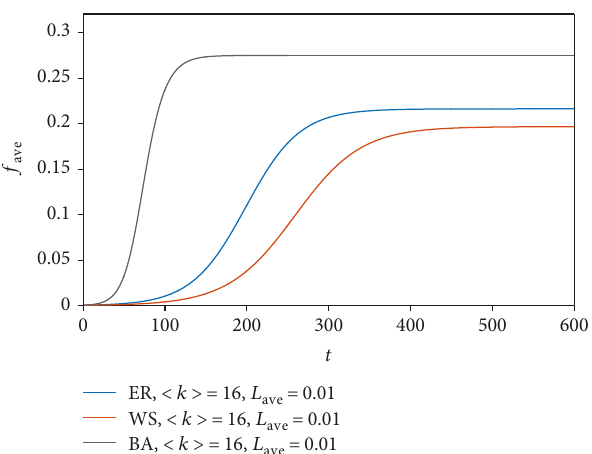
Figure 10: The variation of the average infection degree f time for three networks.